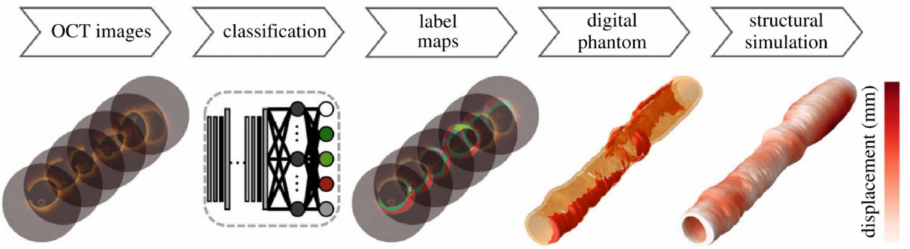
Figure 14. Framework layout for the automated reconstruction and 3D structural simulation of an artery. Initial OCT images were stacked to form a pseudo-3D image sequence before classification with a CNN and generation of label maps which were subsequently smoothed into contours to generate the digital phantom which was converted to a finite element mesh for structural simulation. Republished with permission of The Royal Society Publishing, from [206]; permission conveyed through Copyright Clearance Centre,